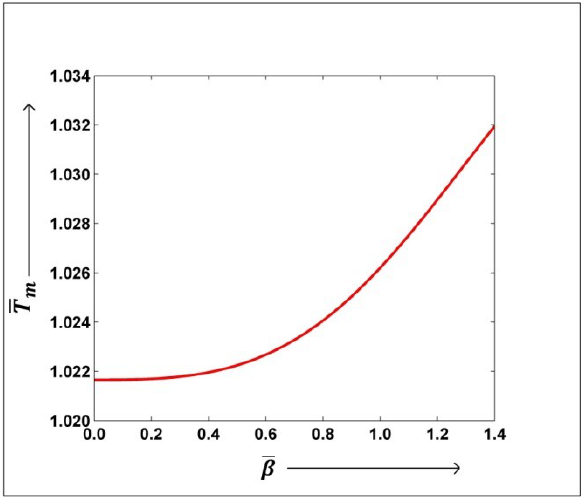
Fig. 2: Mean temperature vs. Permeability parameter at 1/¯ s =